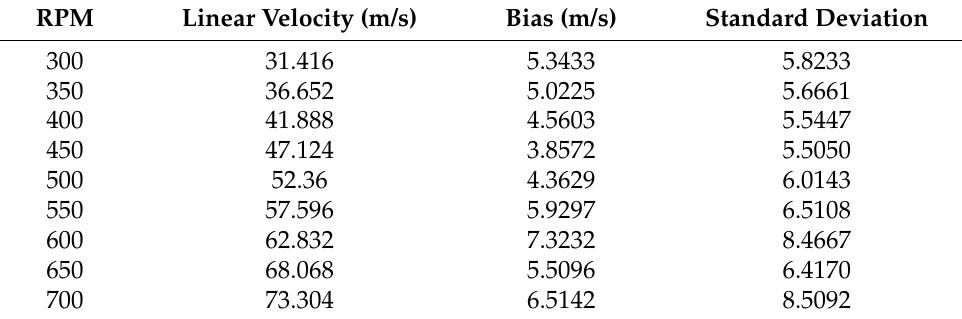
Figure 13. Comparison of estimated relative velocity to true relative velocity (solid lines are estimated values and dashed lines are the real velocity generated by the experimental setup). Table 1. Average of biases at RPMs (between 10 and 70